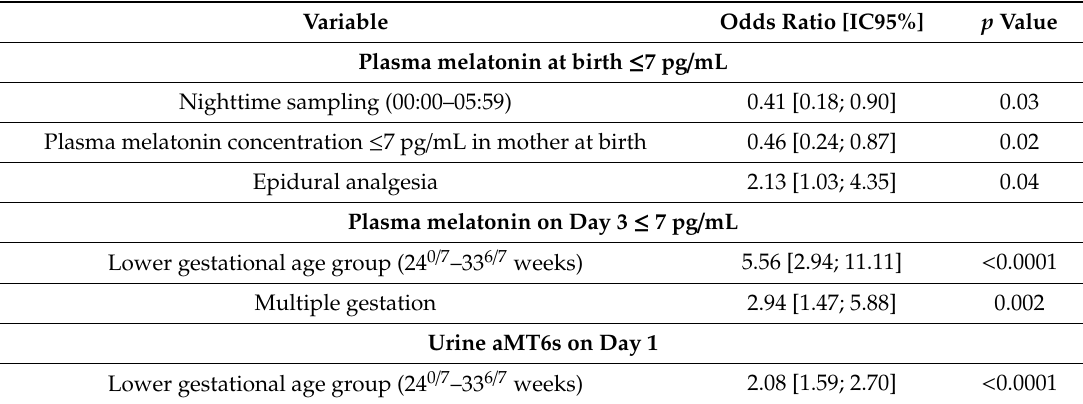
Table 3. Multivariate analyses of factors associated with plasma melatonin deficiency at birth and on Day 3 and urine aMT6s on Day 1. Variable Odds Ratio [IC95%] p Value Plasma melatonin at birth ≤ 7 pg /